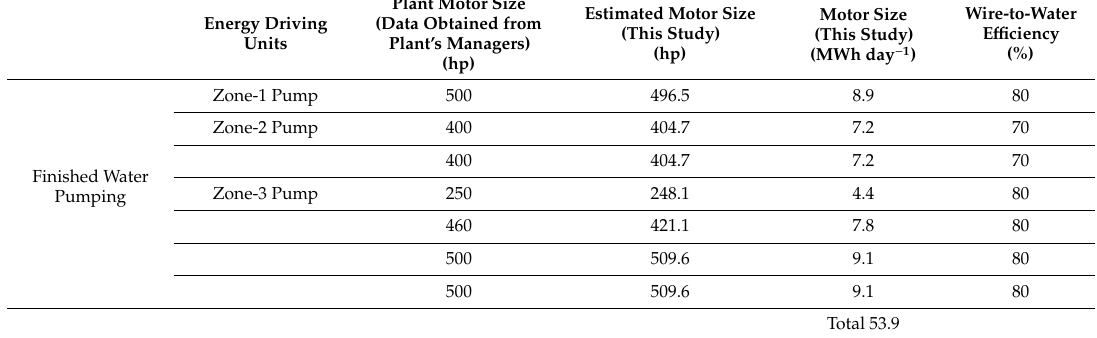
Table 6. Results for estimation of energy consumption for the energy driving units of finished water pumping.